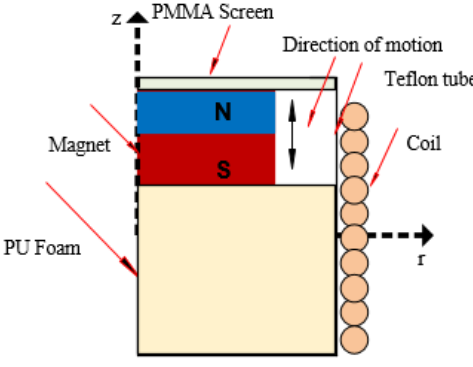
Figure 1. Schematic of a fabricated electromagnetic generator